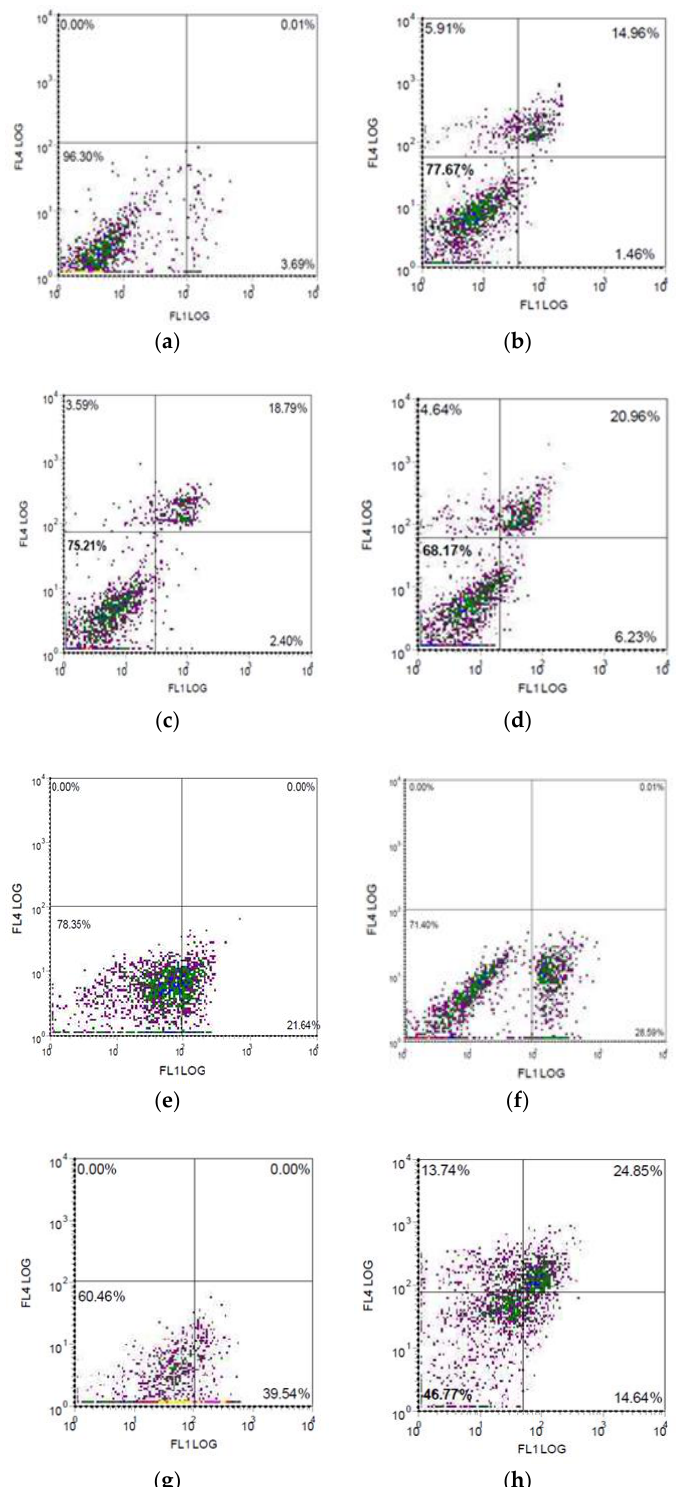
Figure 11. Cytometric analysis of apoptosis in infected melanoma cells stained with Annexin V/PI and analysed by flow cytometry. a . Uninfected mel Mtp cell line at 48 h incubation; b . MV infected mel Mtp cell line at 24 h post infection; c . MV-infected mel Mtp cell line at 48 h post infection; d . MV infected mel Mtp cell line at 72 h post infection. e . uninfected mel Z cell line at 72 h incubation; f . MV infected mel Z cell line at 72 h post infection; g . mel Ibr cell line at 72 h incubation; h . MV infected mel Ibr cell line at 72 h post infection. ОХ— Annexin V (FITC),